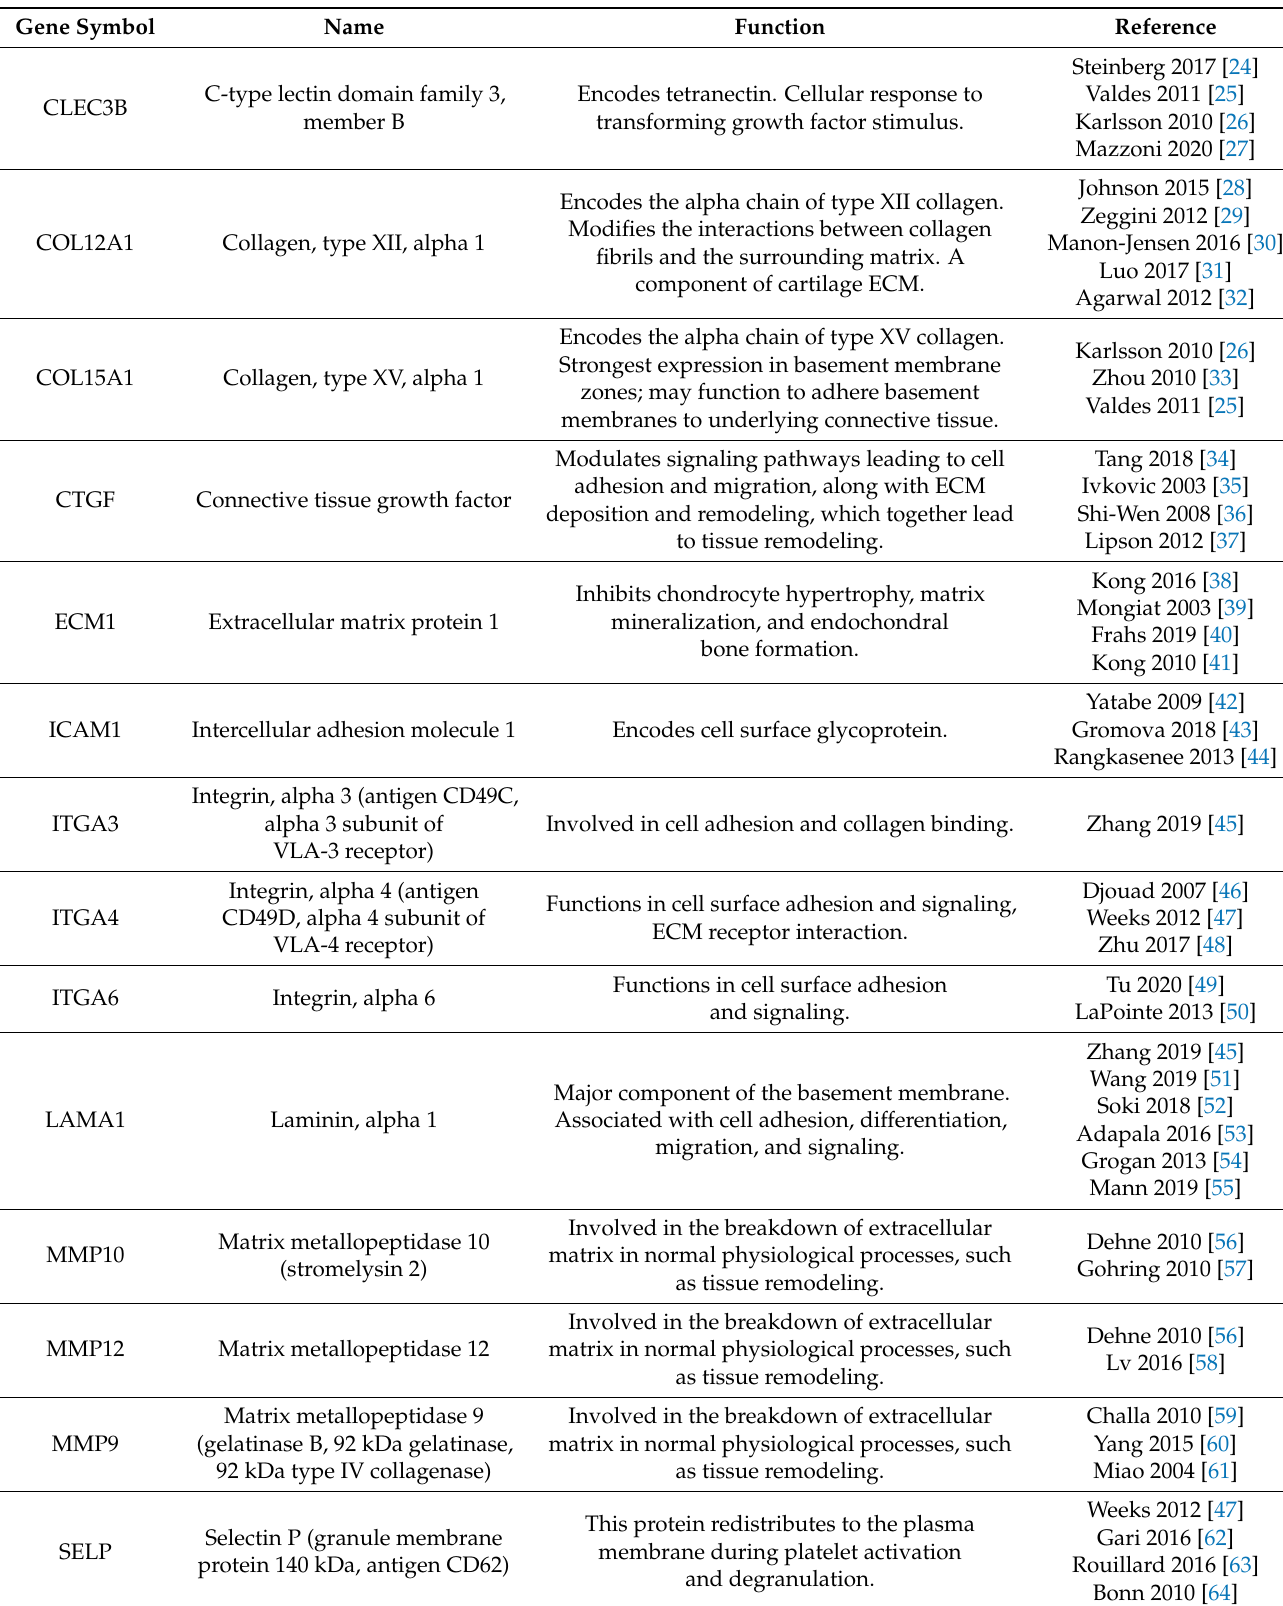
Table 5. Genes unique to scaffold compared to growth on tissue culture